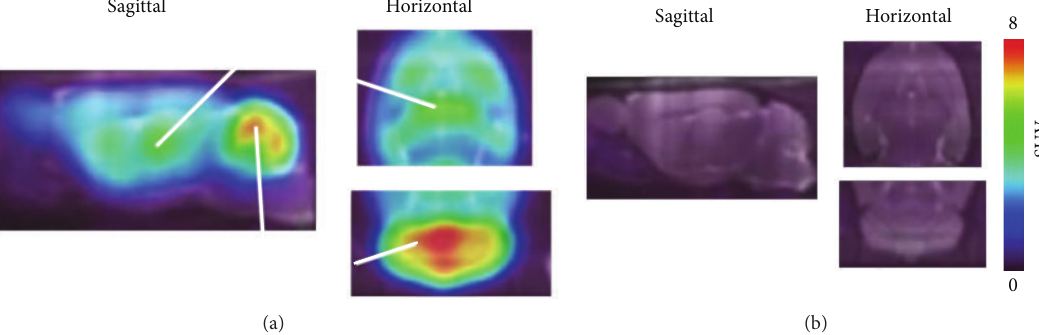
Figure 8: Sagittal PET images (0–60min) of [ 11 C]ITMM in wild-type (a) and mGluR1 knockout (b) mice brains [83].